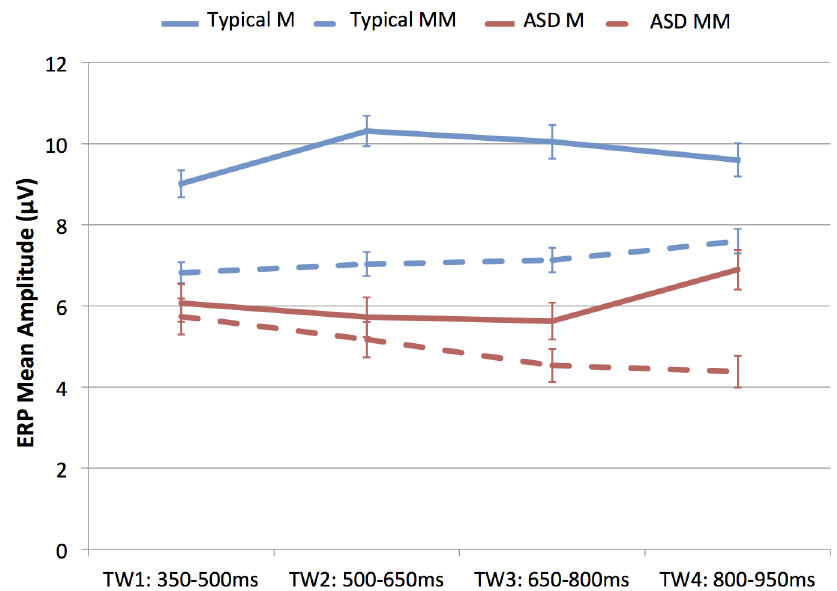
Fig 9. Group x Condition x Time Window interaction on the ERP waveforms time-locked to the word. Mean amplitude and standard error bars of ERP waveforms time-locked to the word for Match and Mismatch conditions (auditory N400 component) at the four time windows for the two groups.